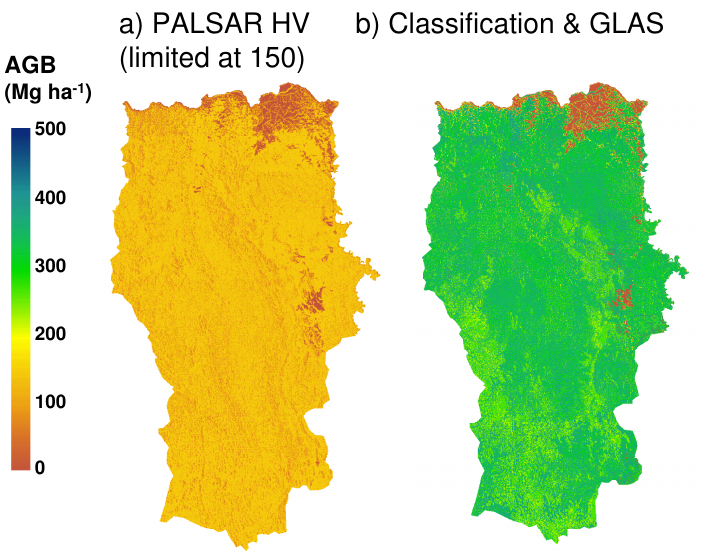
Fig. 7. Two different AGB maps for Lop´e national park are displayed. (a) is for the regression with PALSAR HV, which is limited at 150Mgha − 1 due to the saturation of these data; (b) is for the map produced by classifying PALSAR data and giving the 40 classes AGB values derived from GLAS footprints. Table 2. Mean LiDAR-derived AGB in broad radar-derived biomass classes. AGB class from Mean AGB from LiDAR Standard Deviation Number of PALSAR HV footrpints within this LiDAR-AGB LiDAR